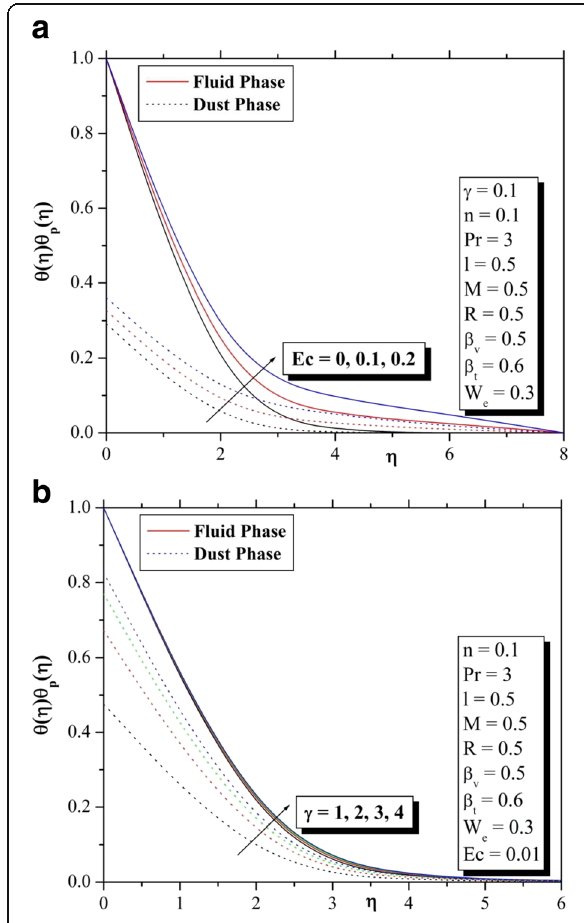
Fig. 7 a and b Temperature profiles for different values of Ec and γ ,